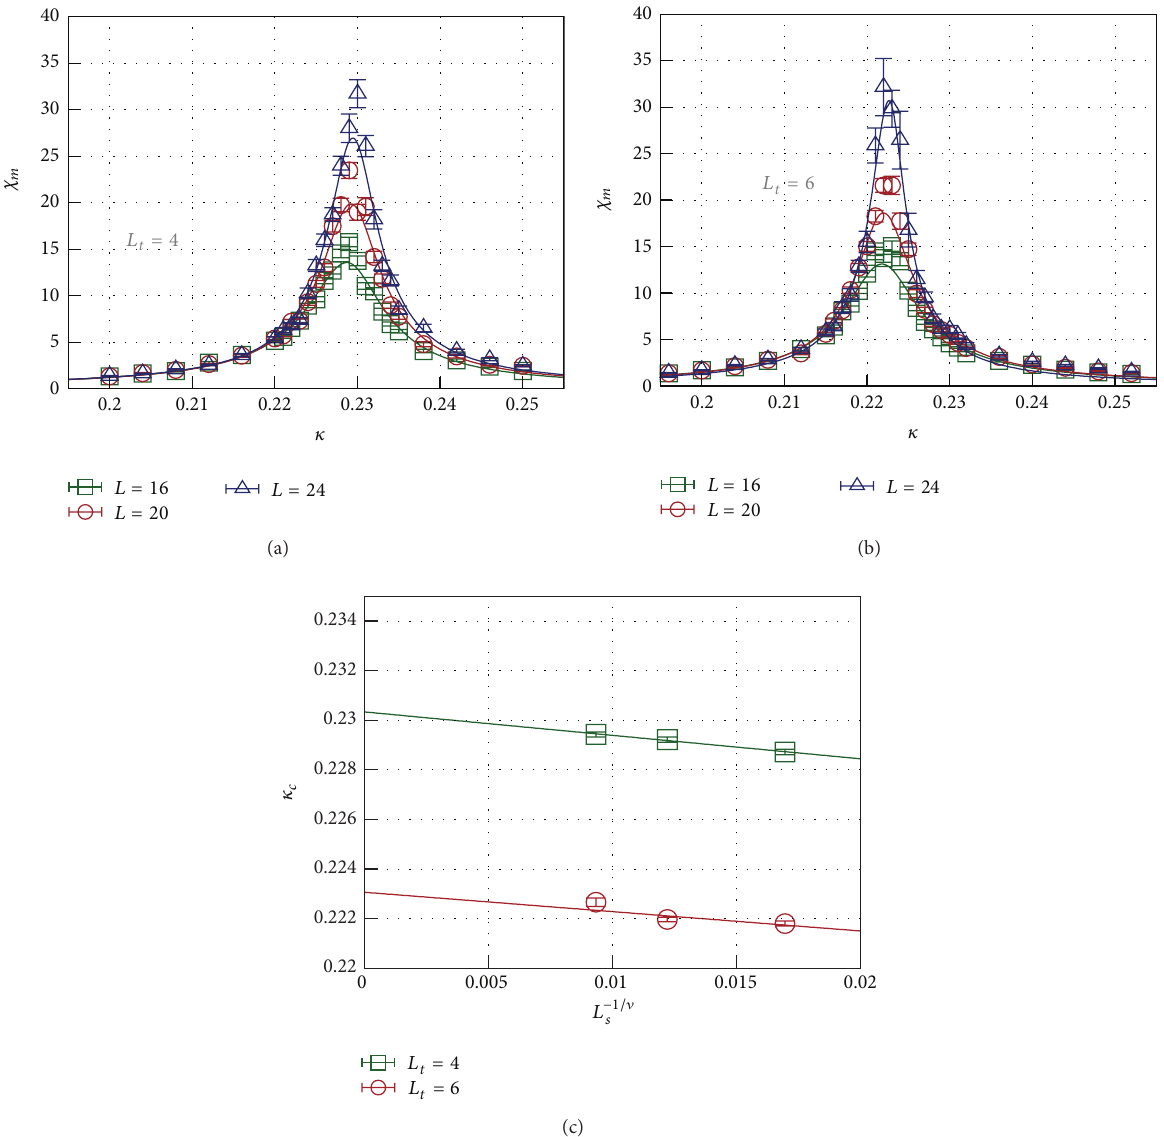
Figure 13: Plots (a) and (b) show the susceptibility as function of 𝜅 at the large fermion mass of about 700 GeV. Plot (c) is the infinite-volume extrapolation for 𝜅 𝑐